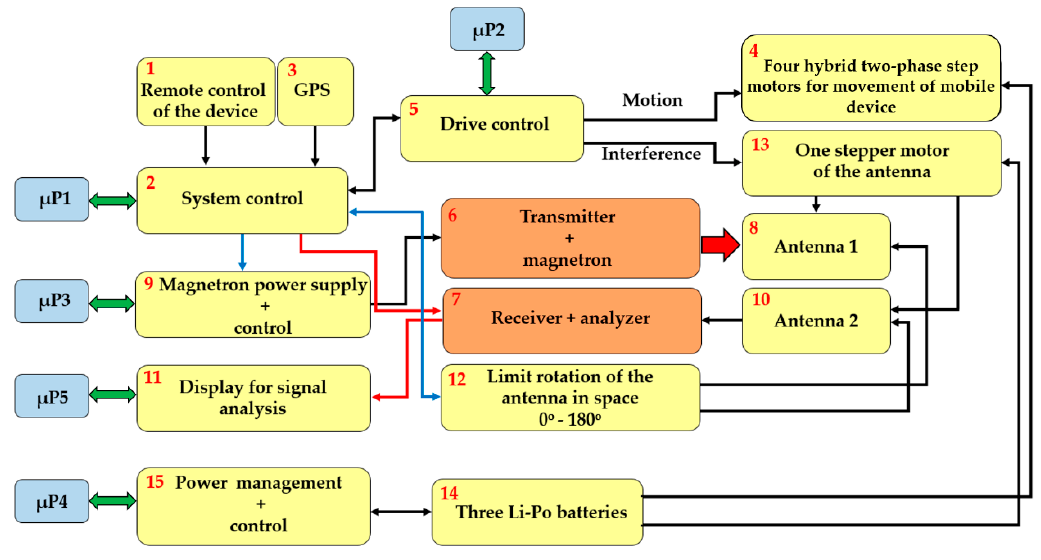
Figure 2. Block diagram of the mobile device.